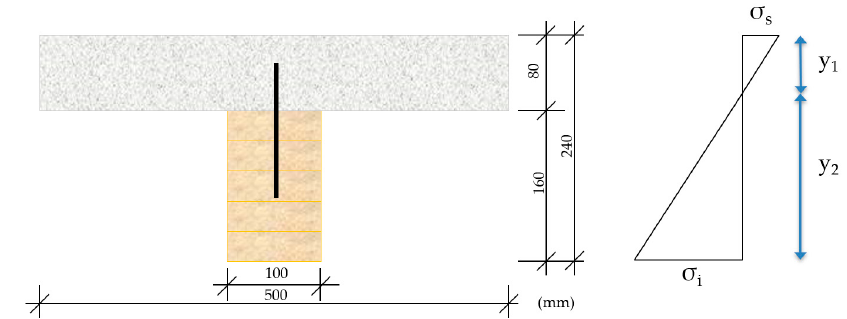
Figure 12. Stress state of the composite wood–mortar section.